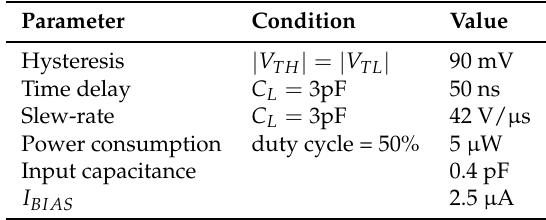
Table 2 sums up the simulated parameters of the operational amplifier used in the integrators. Table 2. Simulated parameters for the operational amplifier ( C L = 3 pF).